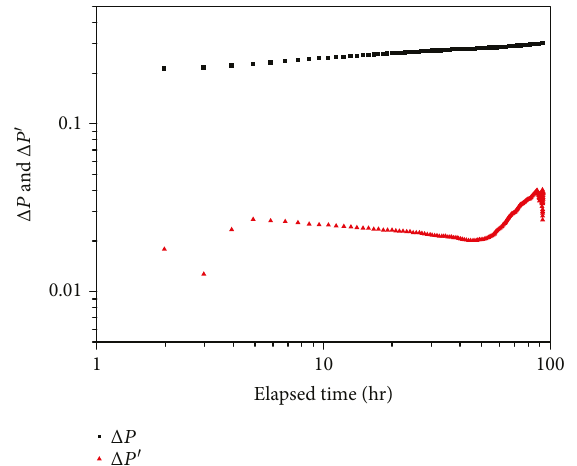
Figure 29: The log-log plot of well B last DD. From this plot, the pressure derivative decreases at late time.